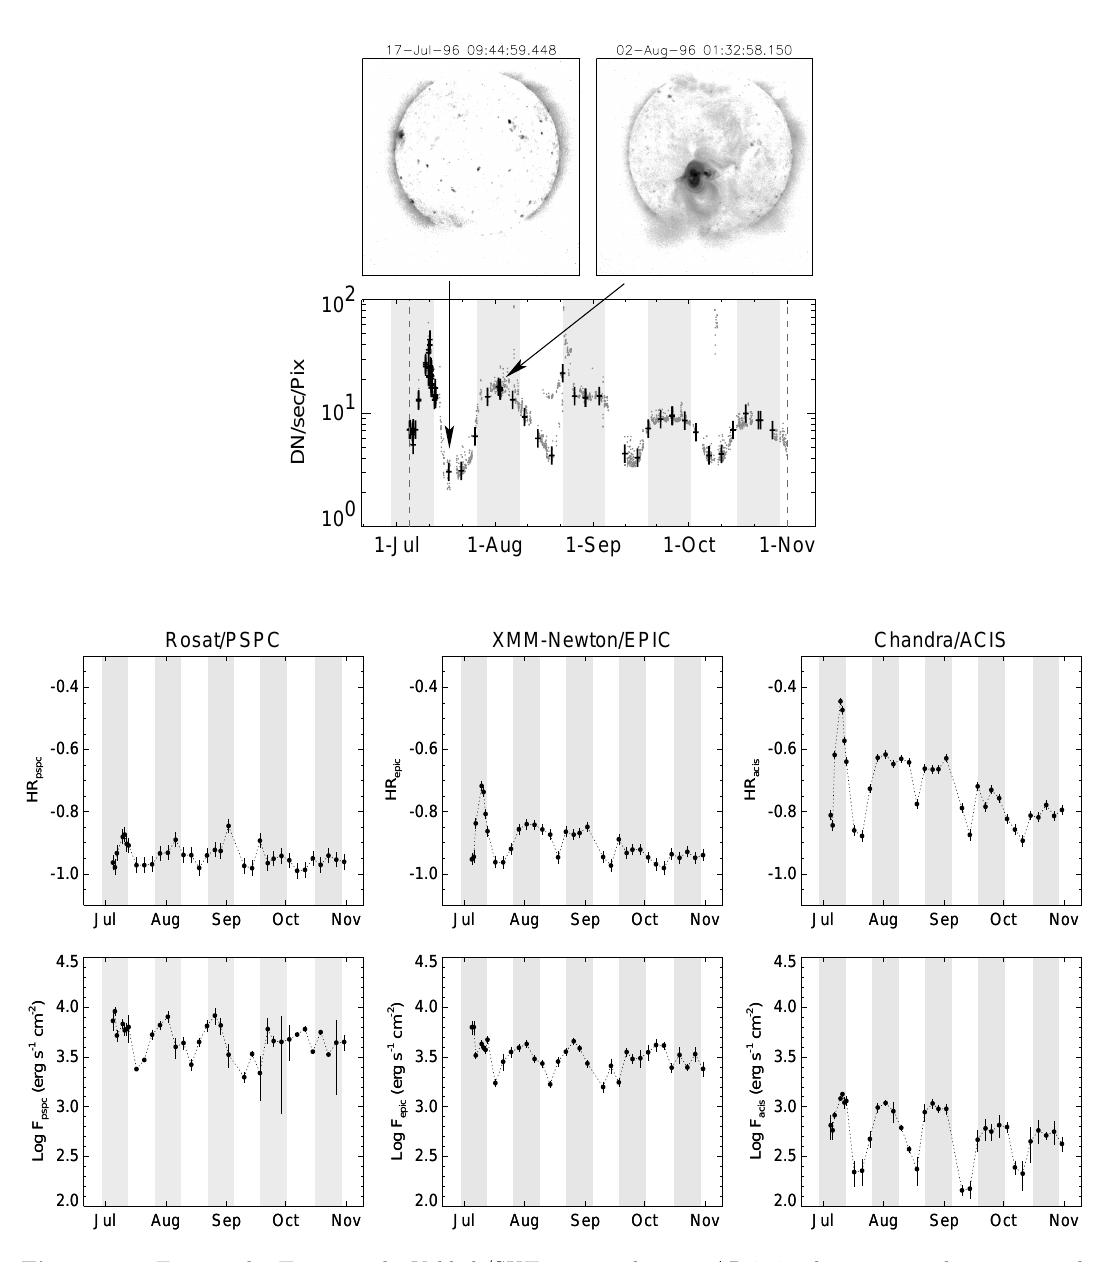
Figure 23: Top panels: Two sample Yohkoh /SXT images showing AR 7978 during its 2nd rotation and the opposite side of the Sun, which had no major AR during the long-term evolution of AR 7978. The lower panel shows the SXT light-curve (thin Al filter) during five rotations, with a decreasing-amplitude rotational modulation and occasional flaring. Bottom panels: Stellar-like representation of the hardness ratio [ 𝐻𝑅 = ( 𝐻 − 𝑆 ) / ( 𝐻 + 𝑆 )], where 𝑆 and 𝐻 are the total counts in the soft and hard part of the spectrum, respectively, and X-ray surface flux in the instruments’ spectral band in the ROSAT/PSPC (0.1 – 3 keV), XMM-Newton/EPIC (0.1 – 10 keV), and Chandra/ACIS (0.5 – 10 keV) bands of the whole solar corona vs. time showing the evolving rotational modulation resulting from the long-term evolution of AR 7978. The grey stripes mark the times when AR 7978 was visible on the disk. Images reproduced with permission from Orlando et al. (2004), copyright by